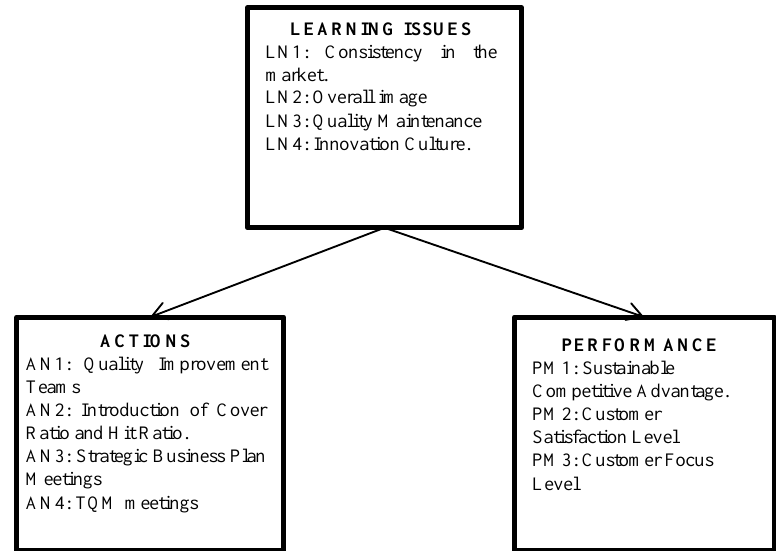
Figure 4. Generic LAP